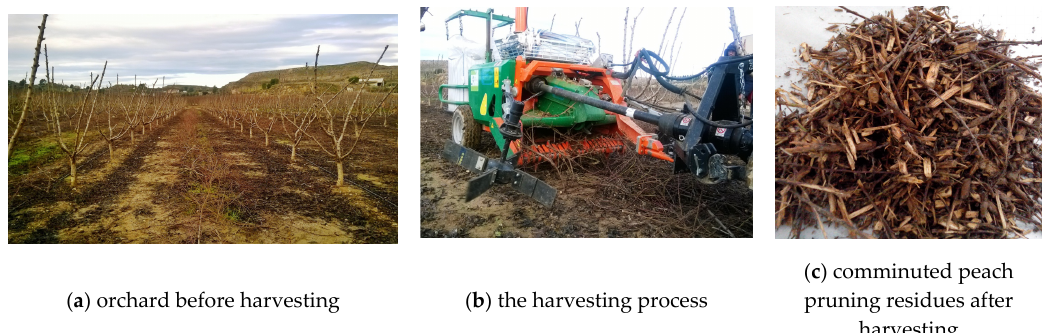
Figure 3. Pruning harvesting in the peach orchard (PtE scenarios). ( a ) orchard before harvesting; ( b ) the harvesting process; ( c ) comminuted peach pruning residues after